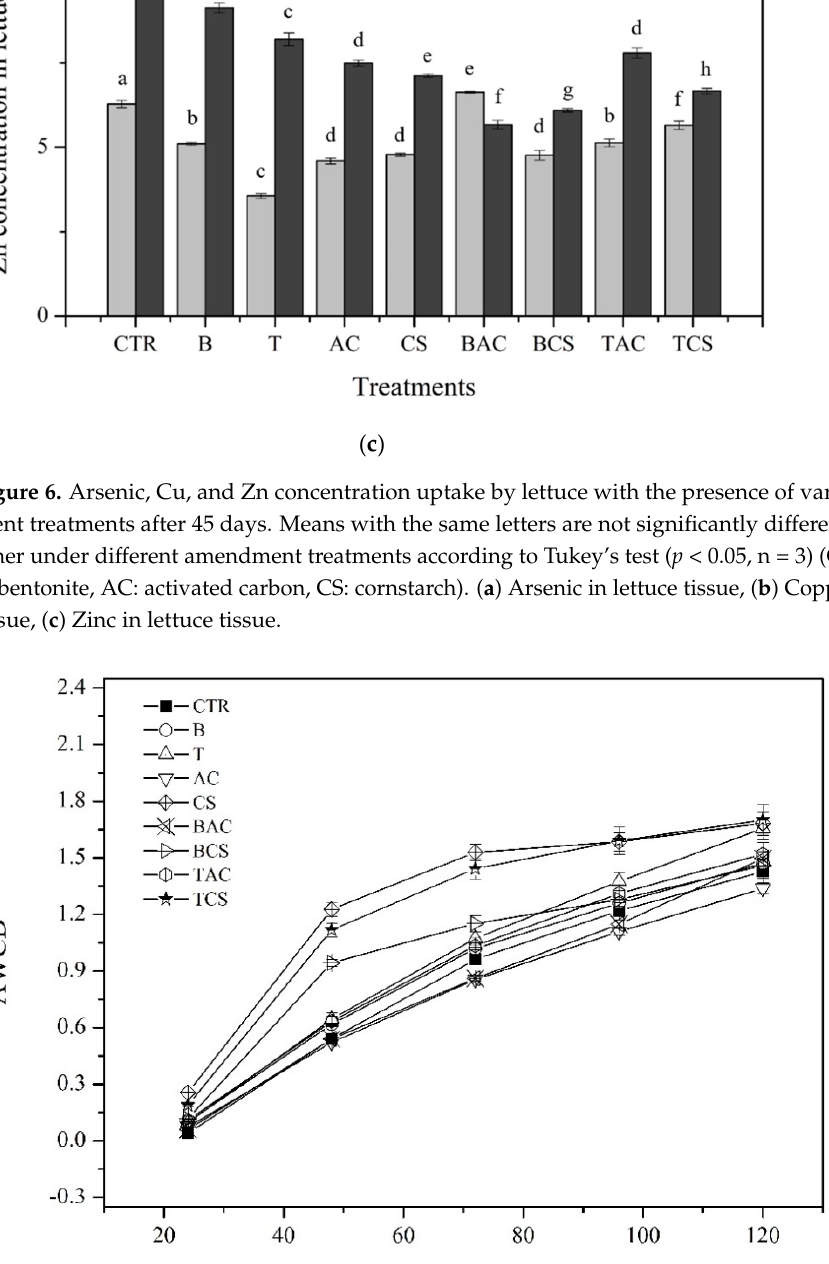
Figure 8. Carbon substrate classification of various amendment treatments after 120 h incubation (CTR: control, B: bentonite, AC: activated carbon, CS: cornstarch). Data are mean ± standard devi- ation (n = 3).